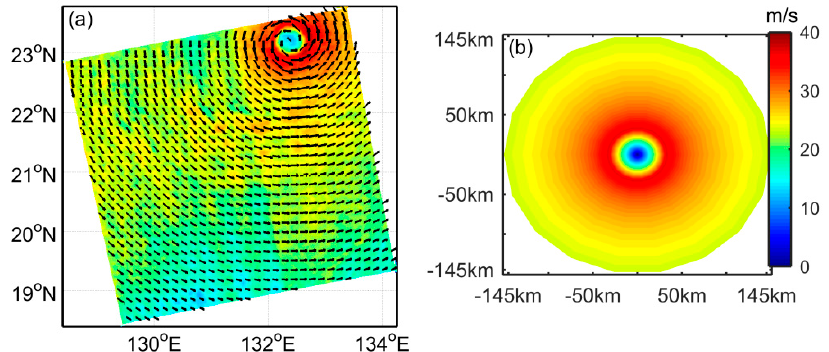
Figure 5. Wind vectors from a VH-polarized SAR image showing: ( a ) Wind speeds in color as retrieved by the C-3PO (C-band Cross-polarization Coupled-Parameters Ocean) model, and directions as estimated by the SHEW (Symmetric Hurricane Estimates for Wind) model; ( b ) Reconstructed wind speeds by the SHEW model.